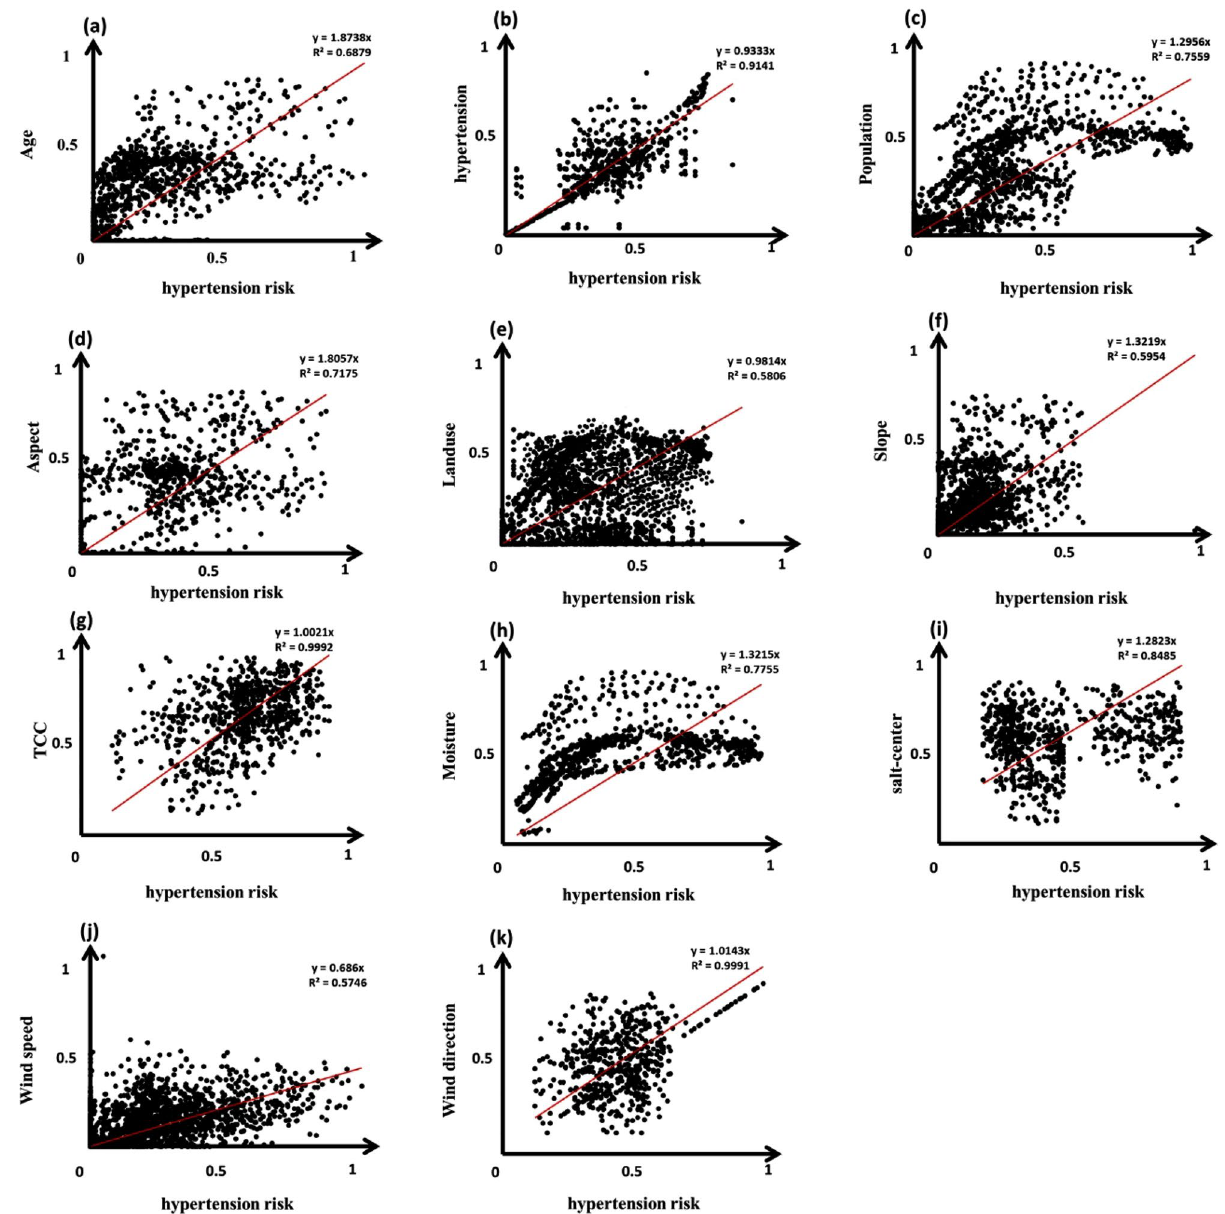
Figure 8. Results of the spatial correlation of the aggregated hypertension map with the selected criteria for health vulnerability and risk mapping: ( a ) age group, ( b ) current status of hypertension, ( c ) population density, ( d ) slope-aspect, ( e ) land use/cover, ( f ) slope, ( g ) vegetation continuous fields, ( h ) soil moisture, ( i ) distance to salt-centers, ( j ) wind speed, and ( k ) wind direction. These plots indicate the contribution of each criterion to the vulnerability and health risk. As can be observed from the plots, all criteria positively correlate with average